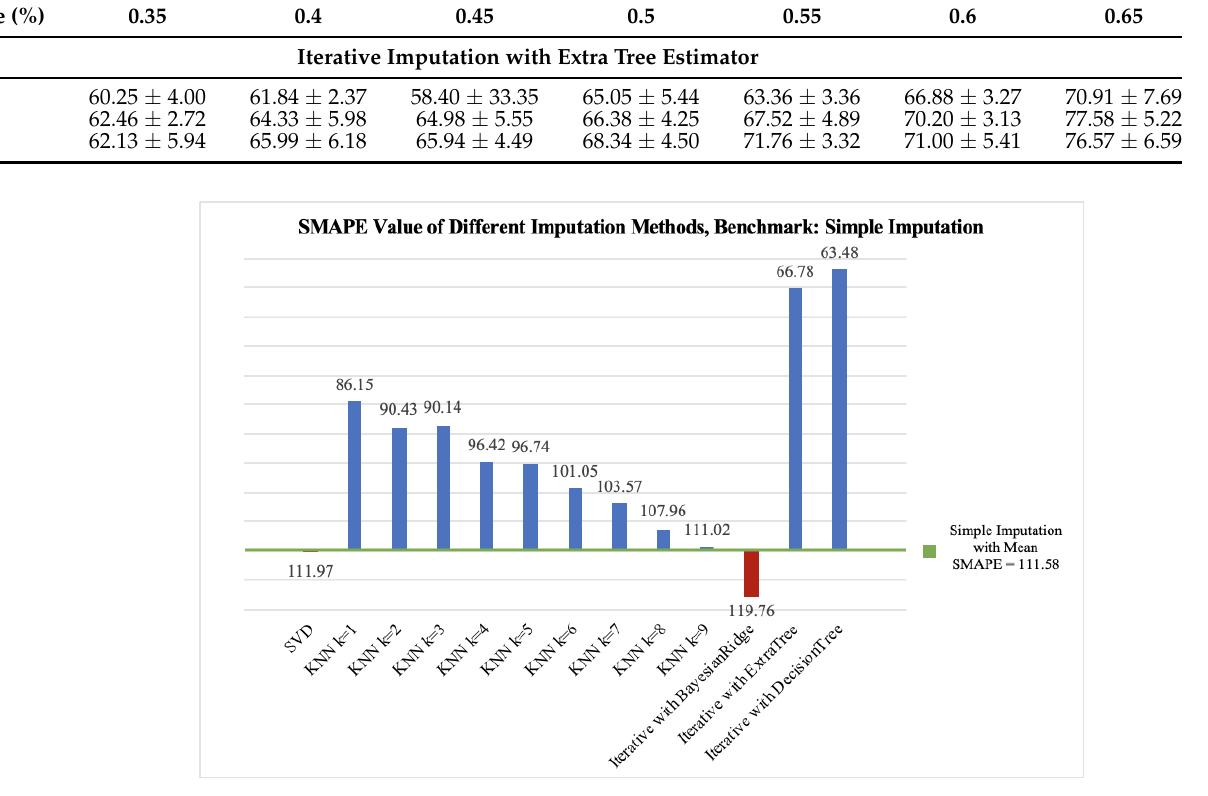
Figure 2. Comparison of the SMAPE value of different imputation methods with simple imputation as the